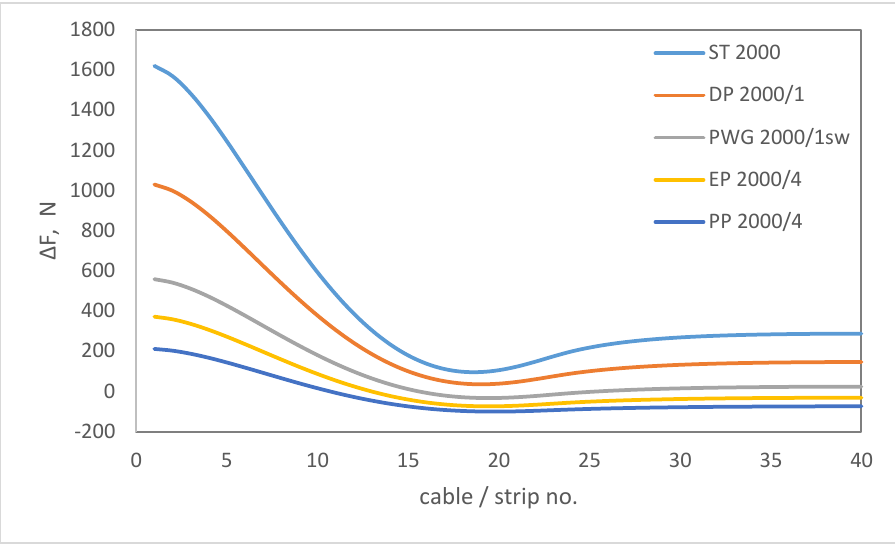
Figure 6. Load increment in the belt in the transition section of the belt conveyor ( L e = 2.6 m, B = 1.2 m, e = 80 mm, α = 45°).